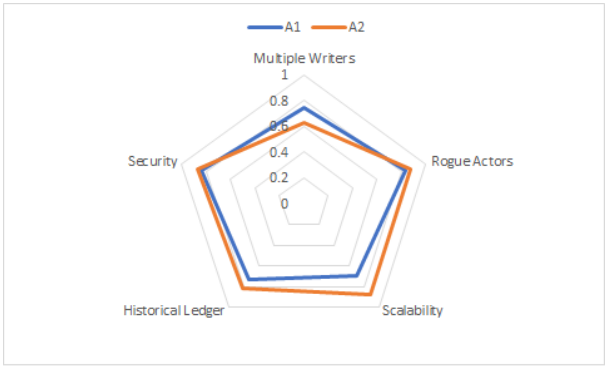
Figure 13. Radar plot: A visual tool for comparing the effectiveness of using a decentralized database for two different applications A1 and A2. A1 is the University Database, and A2 is the Connected Vehicle